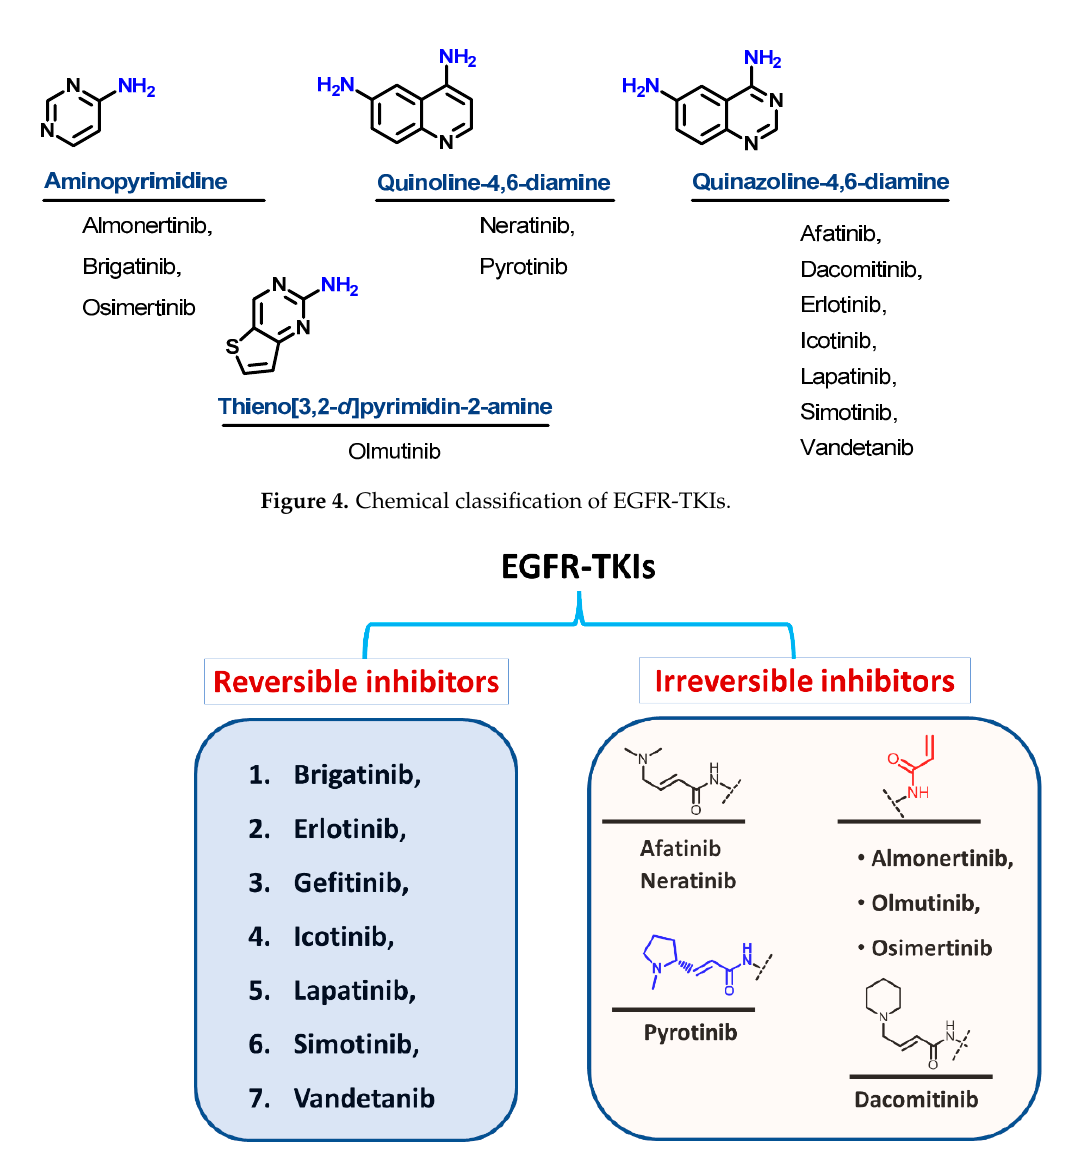
Figure 5. Classification of EGFR-TKIs based on the nature of inhibition of